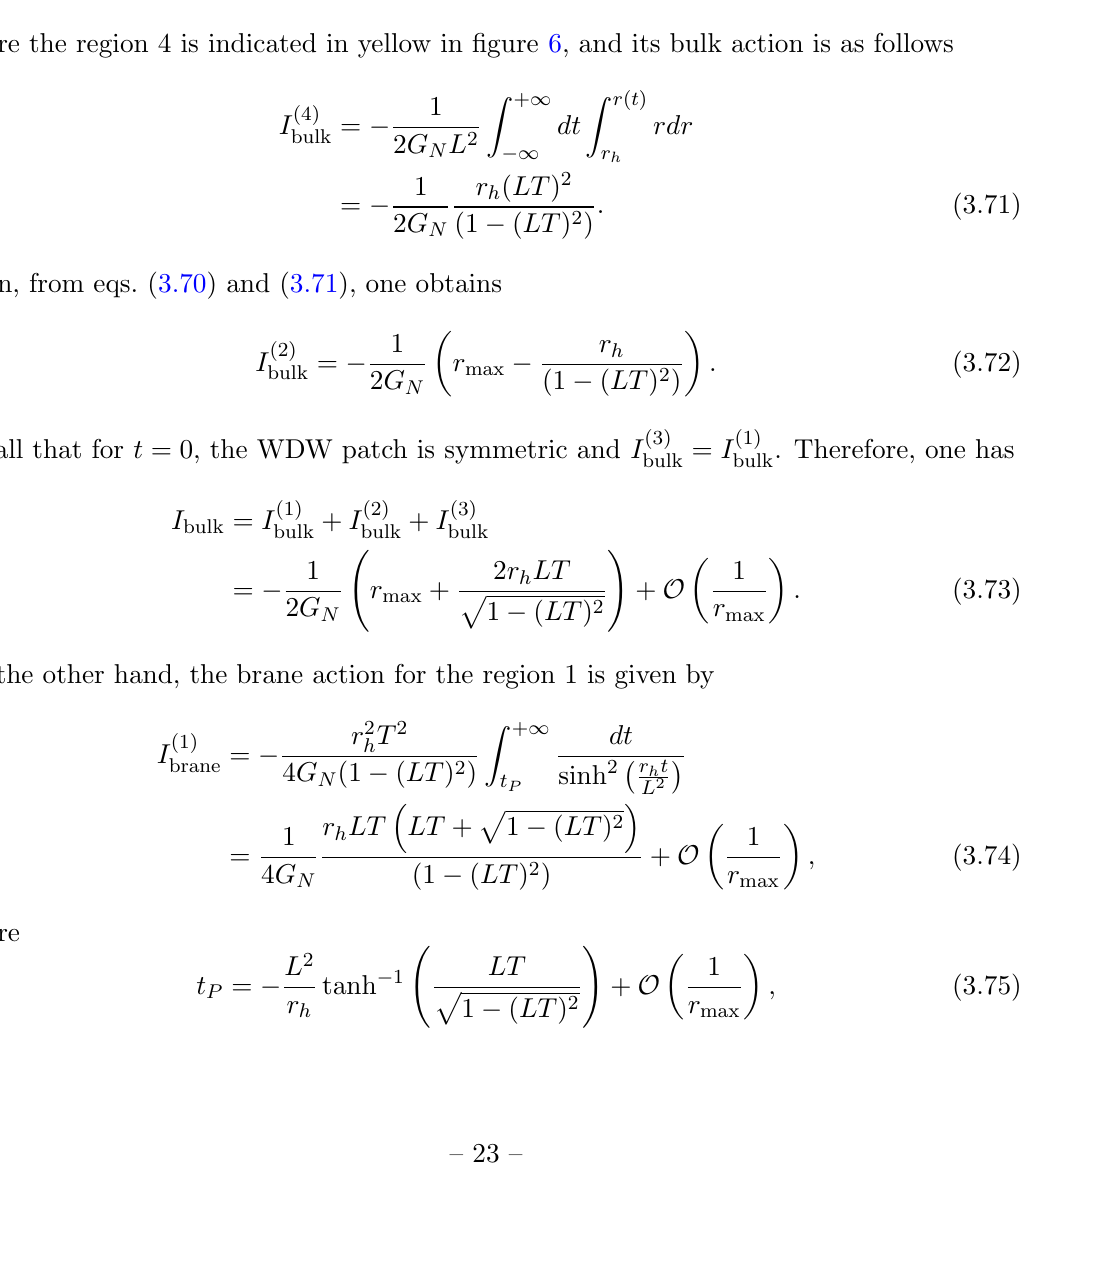
Figure 6 . WDW patch indicated by the cyan shaded region for T < 0 in the left) (cid:12)rst regularization and right) second